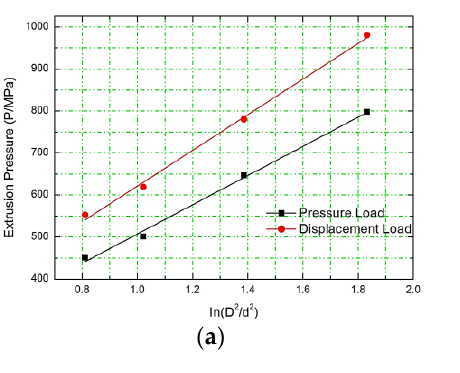
Figure 9. Relationship between ( a ) P and ln R ; ( b ) P and 2α.